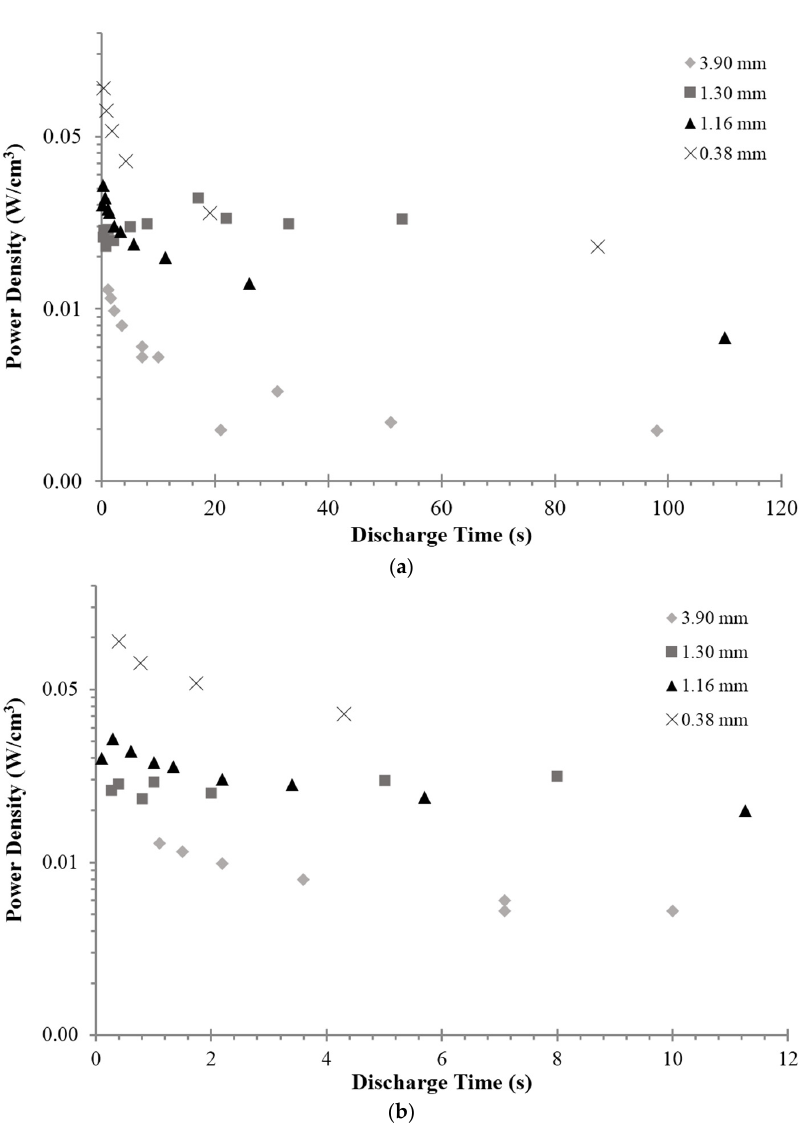
Figure 6. Power as a function of thickness and DT. ( a ) Power density (total energy released in one discharge divided by DT × dielectric volume) increases as the dielectric layer thickness decreases. For DT greater than ~20 s power is nearly constant for any dielectric thicknesses. ( b ) DT values less than 12 s. The delivered power increases as discharge is done more rapidly.